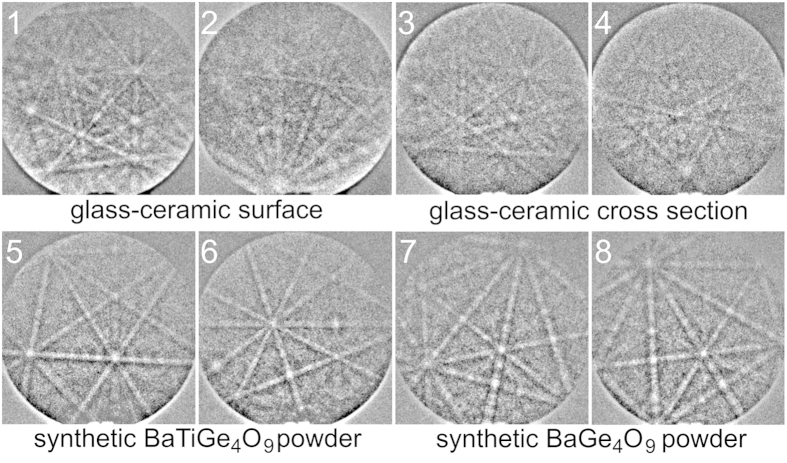
EBSD-patterns acquired from the untreated surface (1,2) and polished cross section (3,4) of the BTG glass-ceramics as well as from synthesized powders of benitoite/BaTiGe3O9 (5,6) and BaGe4O9 (7,8).